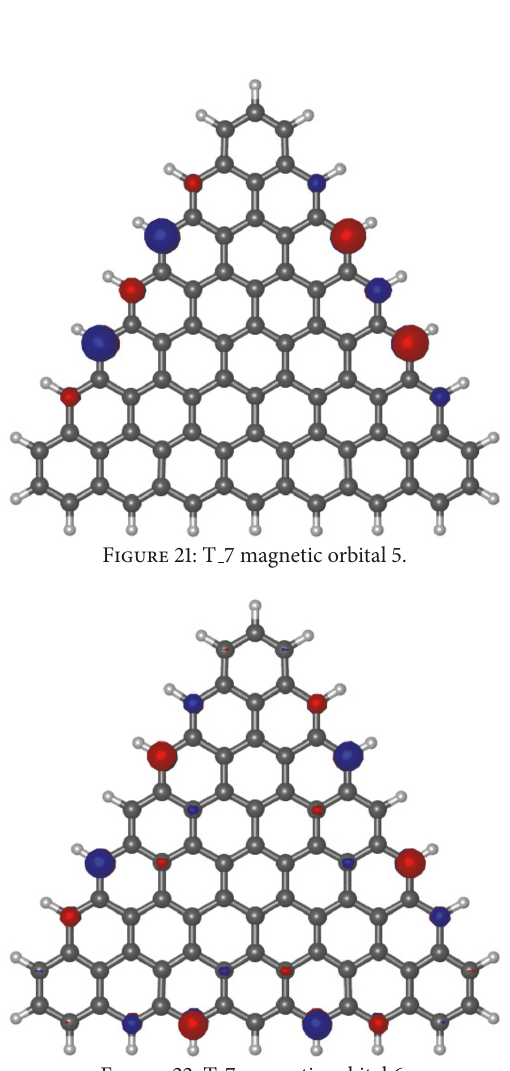
Figure 22: T 7 magnetic orbital